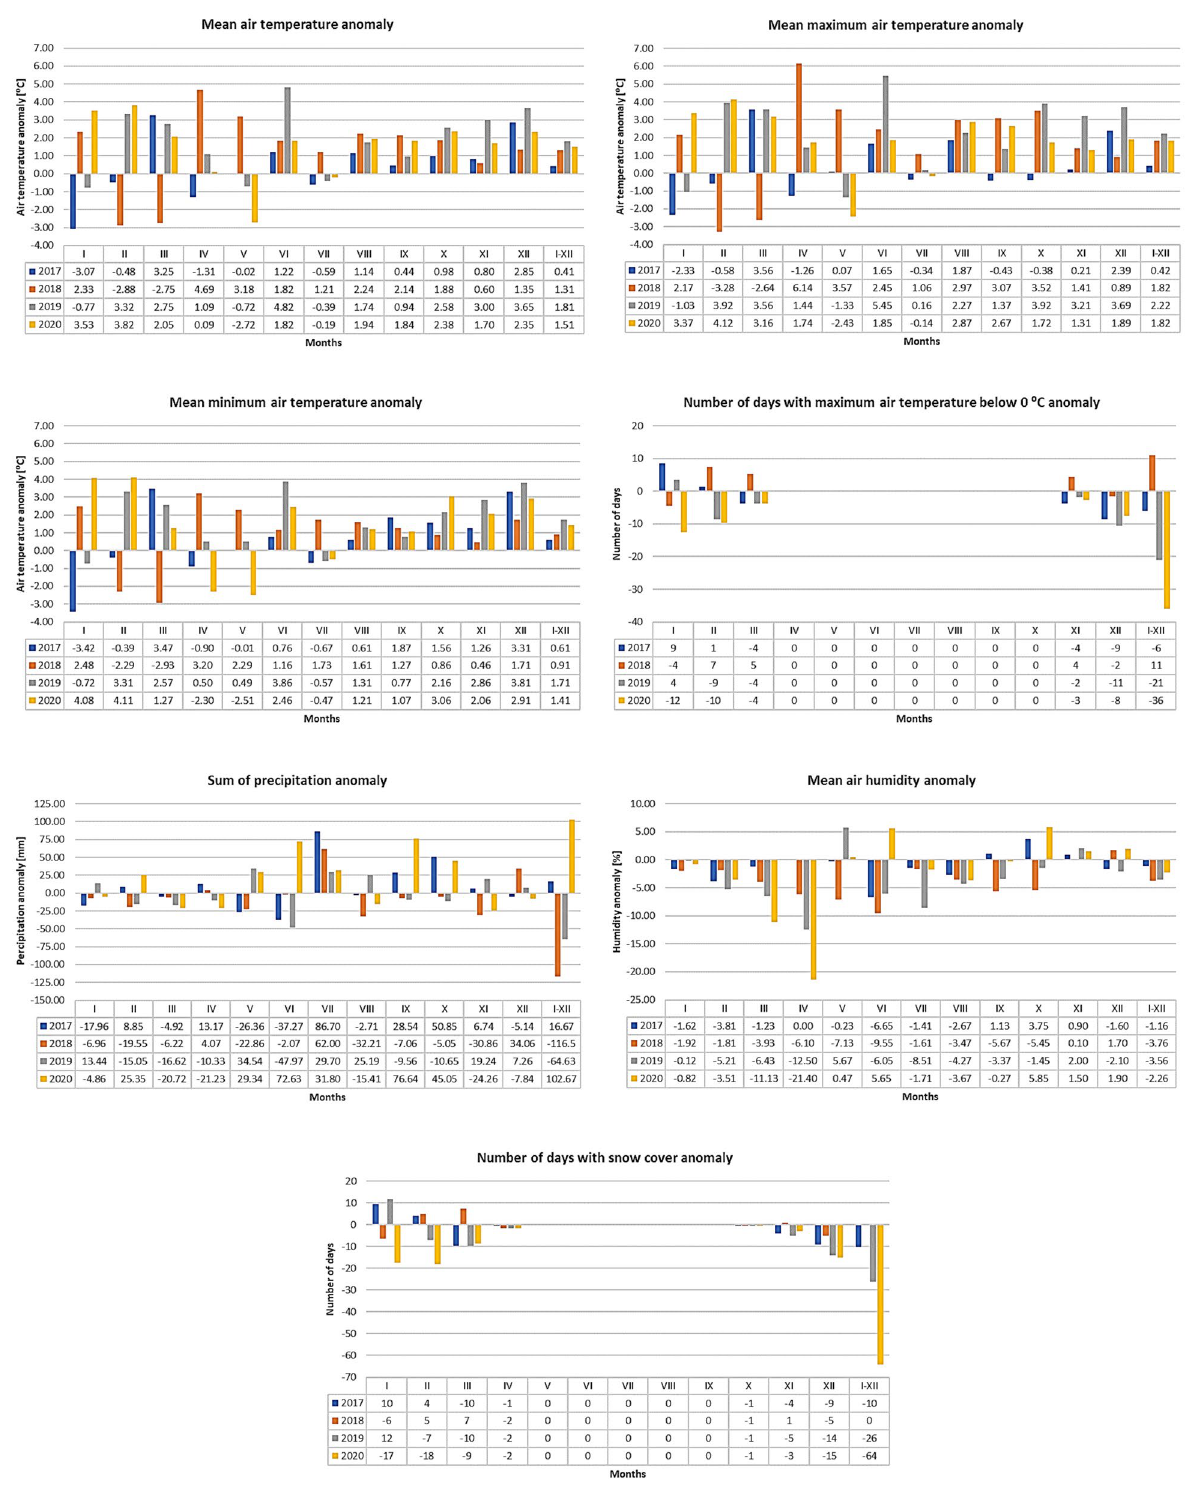
Figure 1. Anomalies of weather conditions in 2017–2020 compared to the multi-year reference period